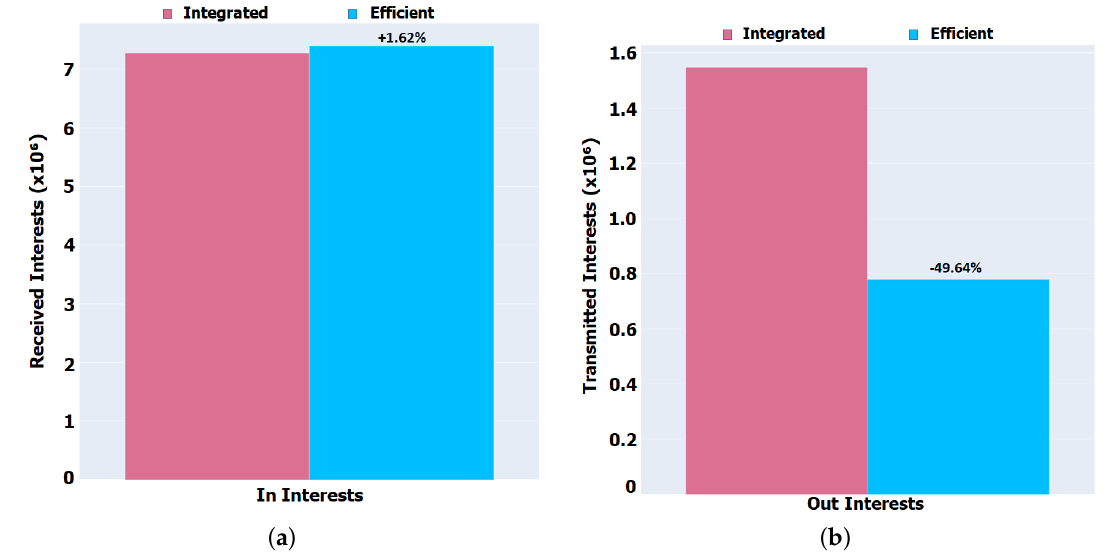
Figure 10. Global received and transmitted Interests packets for Porto scenario. ( a ) In Interests.